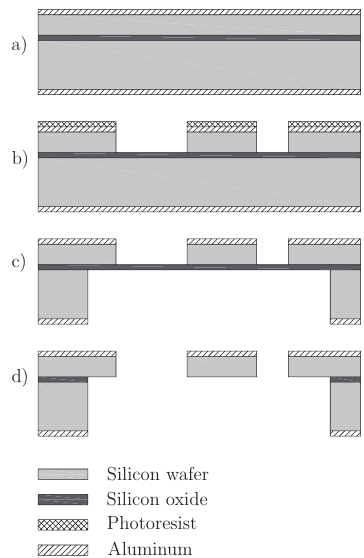
Figure 7. Process phases adopted for the realization of the device. ( a ) Deposition of aluminum layer on both wafer sides by magnetron sputter deposition; ( b ) DRIE process applied to the device layer; ( c ) DRIE process applied to the handle layer; ( d ) etching of the exposed silicon dioxide